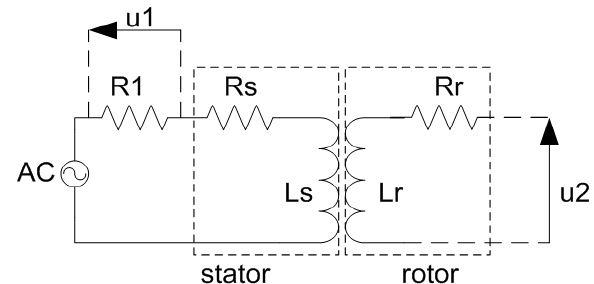
Figure 7. Illustration of the equivalent circuit for the mutual inductance